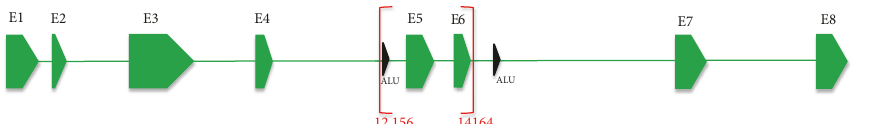
Figure 4: NG 009625.1:g.12156 14164del2009 in SERPING1 (red brackets), and the nearest Alu element sequences (black arrows) relative to this 2,009 bps deletion. The 5 󸀠 end of the deletion breakpoint is 16 bps from the adjacent Alu element, while the 3 󸀠 end is approximately 1 kbps away from the nearest Alu sequence. Please note the diagram is not in exact